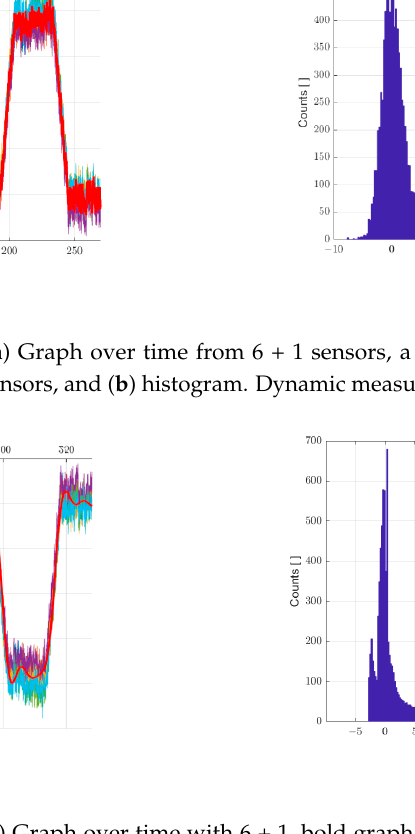
The tests conducted until now were carried out in a closed room without forced air movement. The next two sets of tests present results for forced air movement with the windmill from Figure 3. The windmill was intended to simulate difficult realistic measurement conditions with potential applications of the system in an open space. The windmill periodically oscillated the blowing direction +/ − 30 degrees. The speed of the generated wind was set at 3.0 m/s. The first set of measurements were static tests (sensor system at standstill), as shown